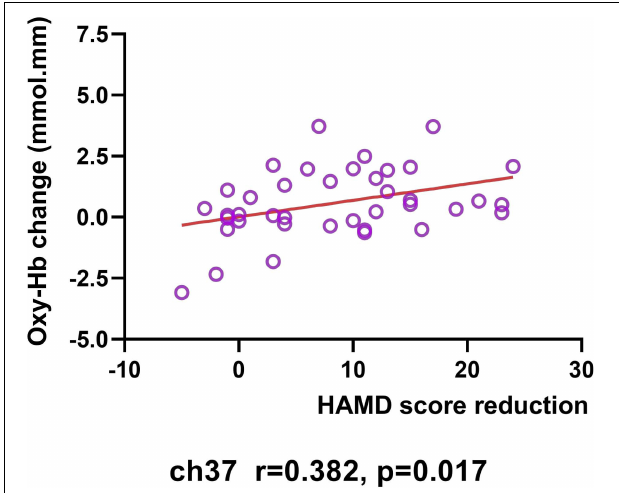
FIGURE 5 | Correlation between HAMD score reduction and changes in [oxy-Hb] value (from baseline to post-treatment) in